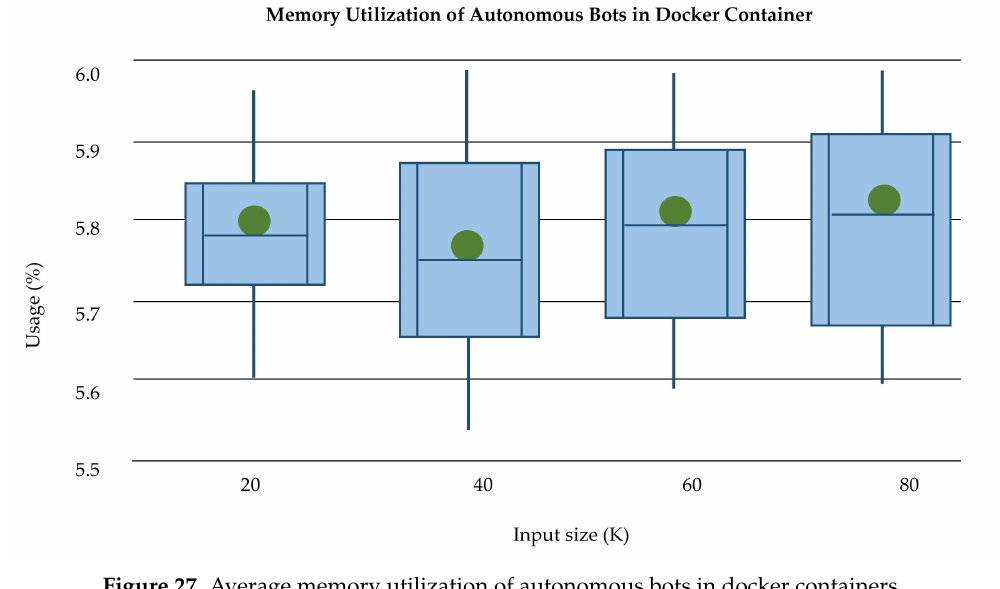
Figure 27. Average memory utilization of autonomous bots in docker containers.